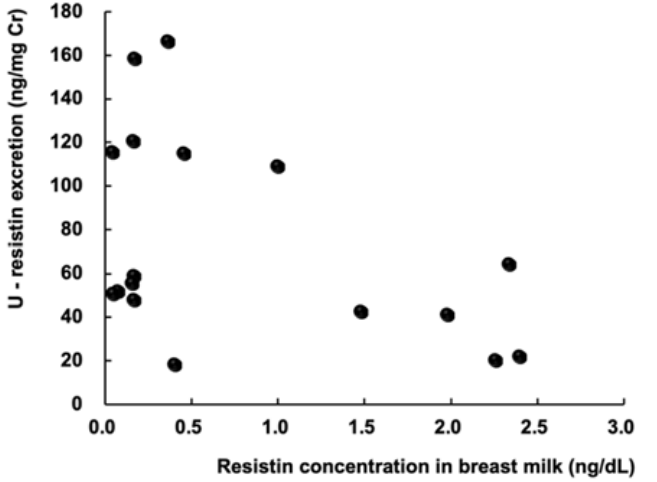
Figure 3. Association between urinary resistin level in breast-fed infants and resistin concentration in the mother’s breast milk.